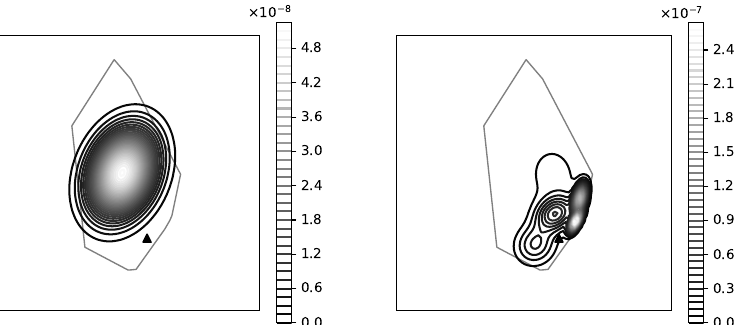
Figure 10. RF signal strength distribution approximated by baseline method ( left image ) and proposed one ( right image ). The baseline method estimates a multivariate normal distribution using the polygon shape only. The proposed method estimates a mixture of Gaussians using the samples of the RF signal strength within the polygon area.